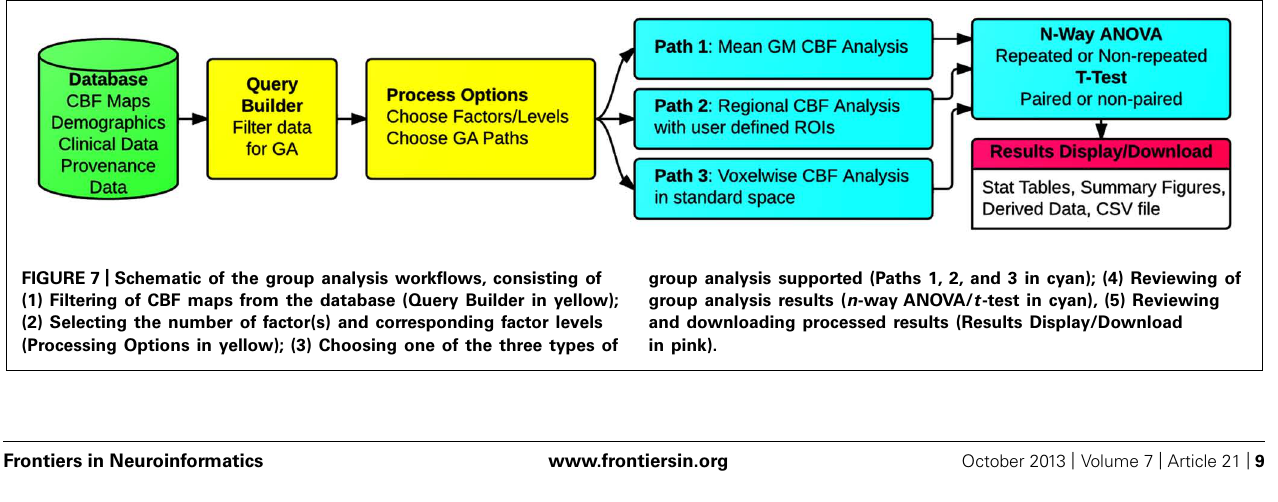
FIGURE 7 | Schematic of the group analysis workflows, consisting of (1) Filtering of CBF maps from the database (Query Builder in yellow); (2) Selecting the number of factor(s) and corresponding factor levels (Processing Options in yellow); (3) Choosing one of the three types of